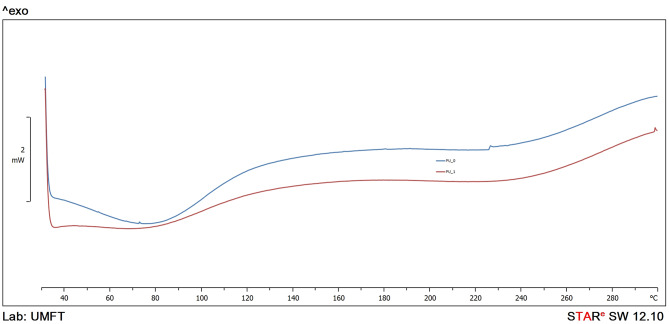
DSC thermograms of chitosan-based PU structures.